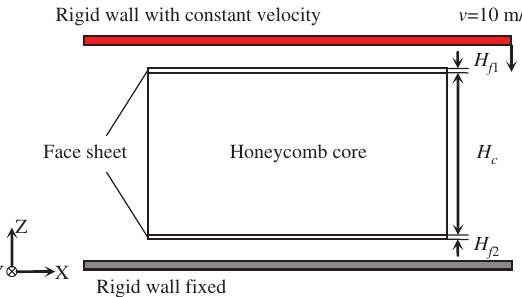
Figure 1: Schematic diagram of HSP under axial